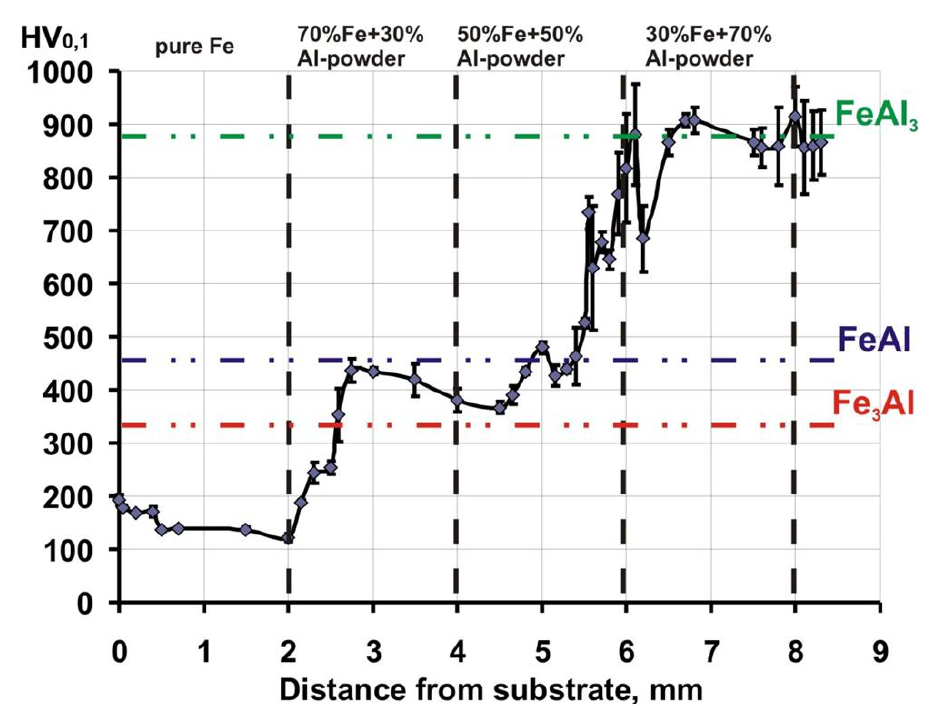
Figure 4. Microhardness distributions of Fe–Al FG multilayer